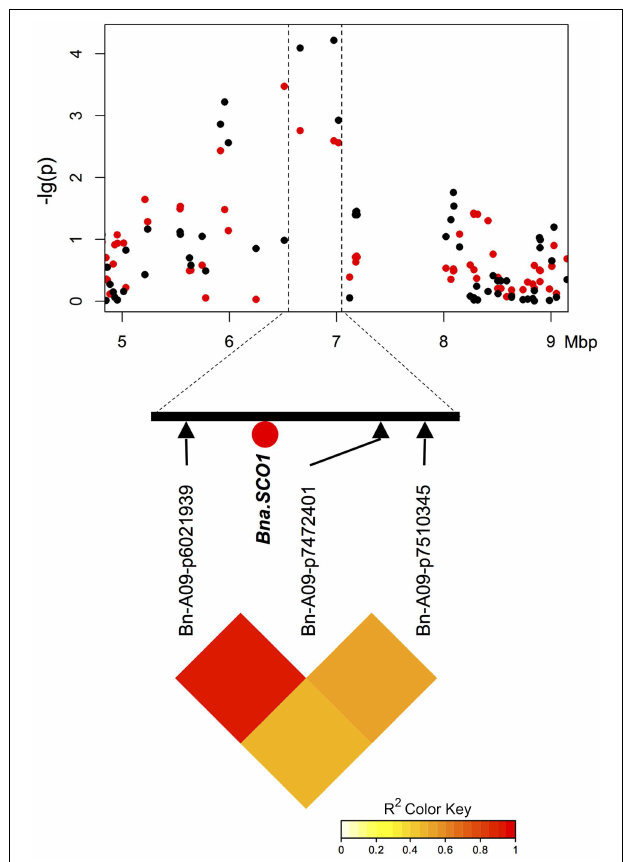
FIGURE 5 | Manhattan plot describing marker-trait associations for the trait T50 within the chromosomal region around candidate BnaA09g12770D (Bna.SCO1) on chromosome A9, and correlations between the associated marker and both flanking markers. Red dots represent associations calculated for SL2011. Black dots represent associations for SL2012.